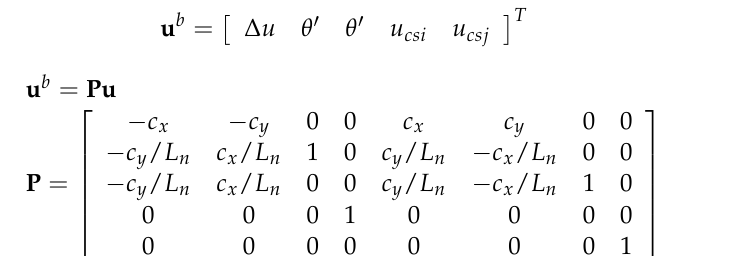
Eliminating the rigid body displacements, the main deformation modes of the element can be labeled axial deformation, rotational deformation and slip deformation, as shown in Figure 3. The basic deformation vector u b can be expressed as Equation (3). The transformation relation between u b and u is shown in Equation (4). c x = ( L + ∆ u x )/ L n , c x = ∆ u y / L n . L is the initial element length and L n is the deformed element length. ∆ u x and ∆ u y denote relative displacement along the local x and y axes, respectively.